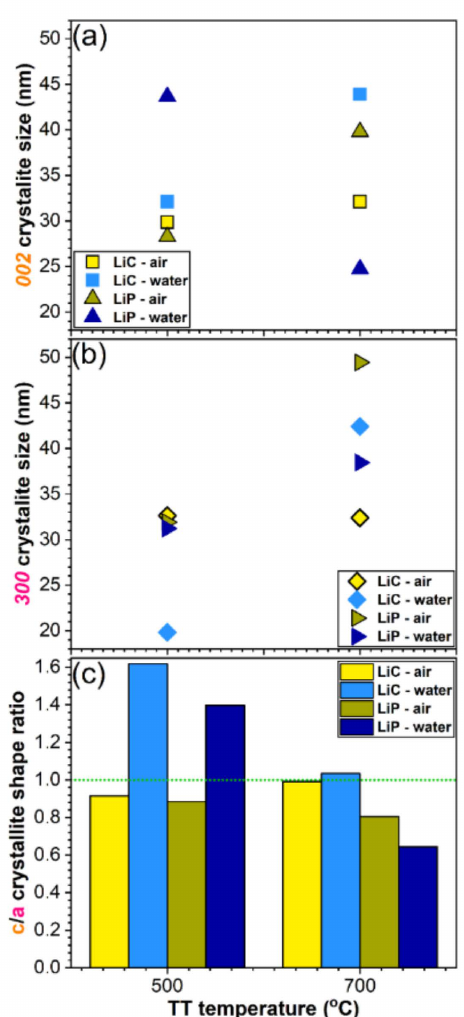
Figure 2. Average crystallite sizes determined by Scherrer equation along the ( a ) c -axis and ( b ) a -axis for the HA constituent phase of the LiC and LiP samples heat-treated in air and water-vapor ambient at 500 and 700 ◦ C, respectively. ( c ) Crystallite shape anisotropy